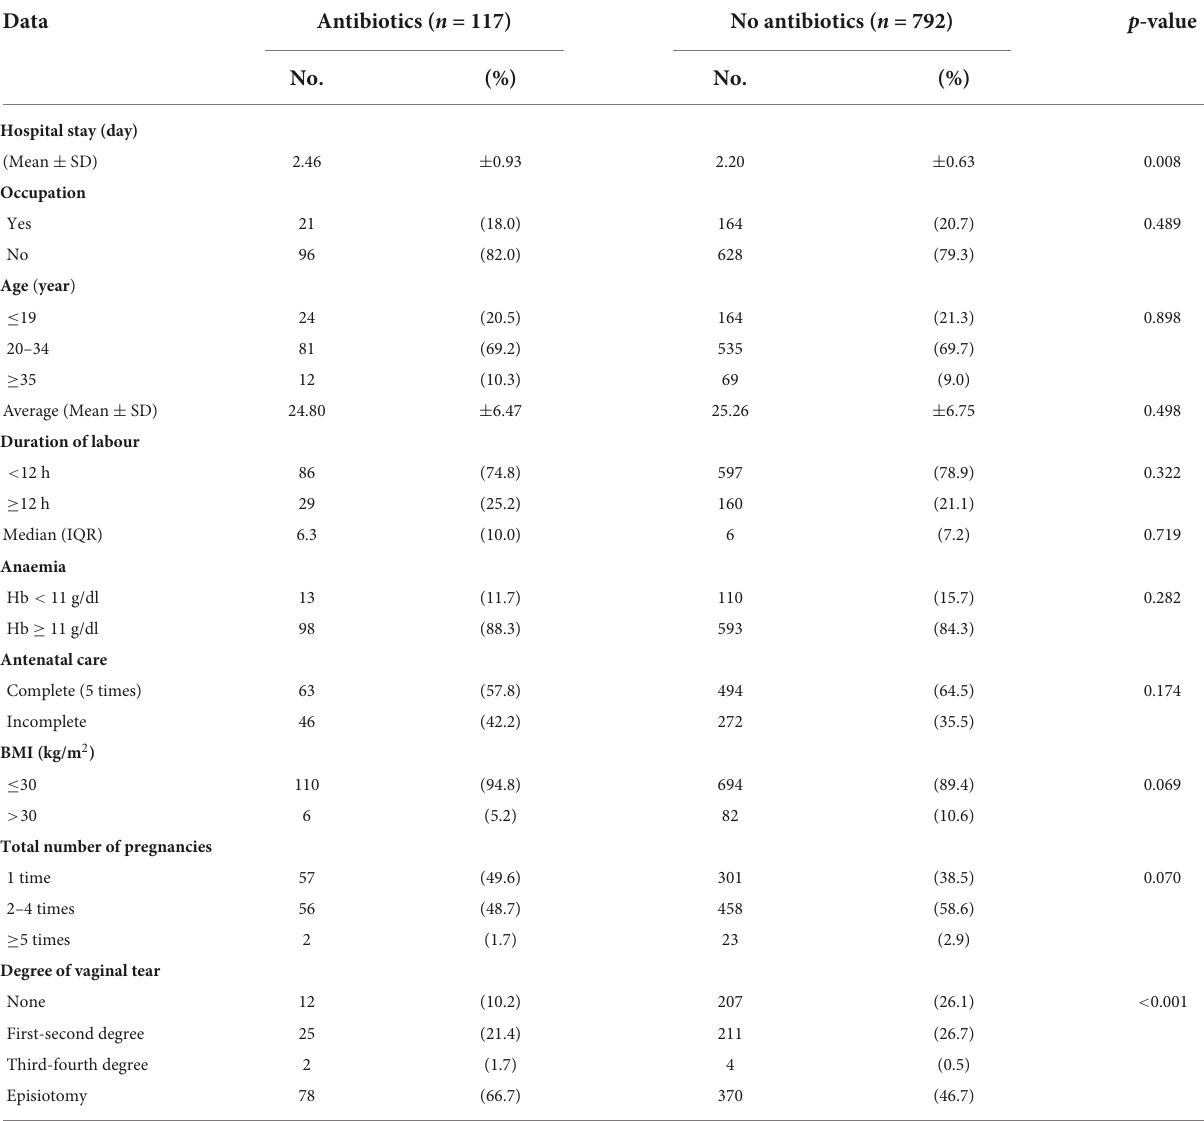
TABLE 1 Baseline characteristics.